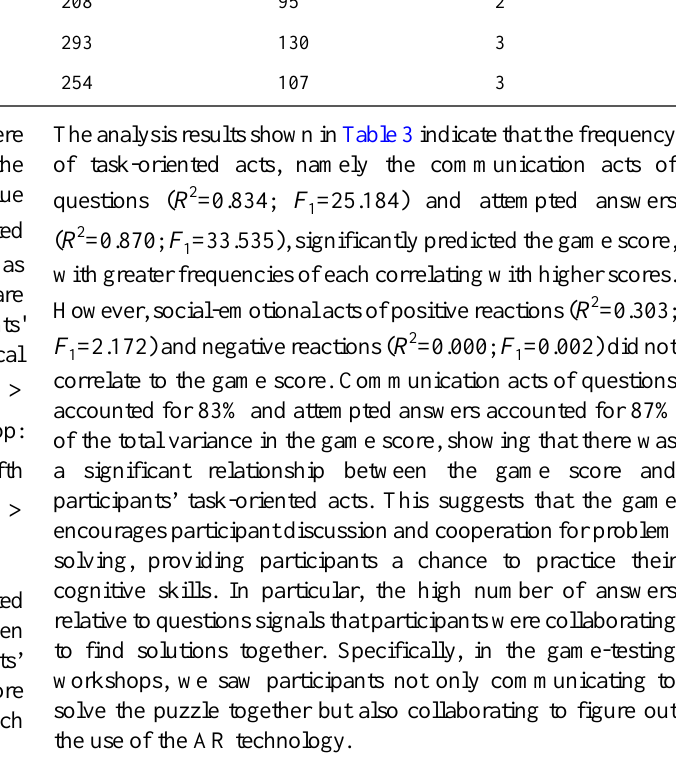
QuestionsAttempted